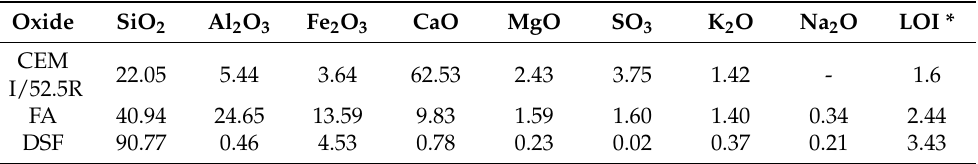
Table 2. Chemical composition of Portland cement and pozzolanic materials (%). FA= fly ash; DSF: densified silica fume. * indicates loss on ignition.